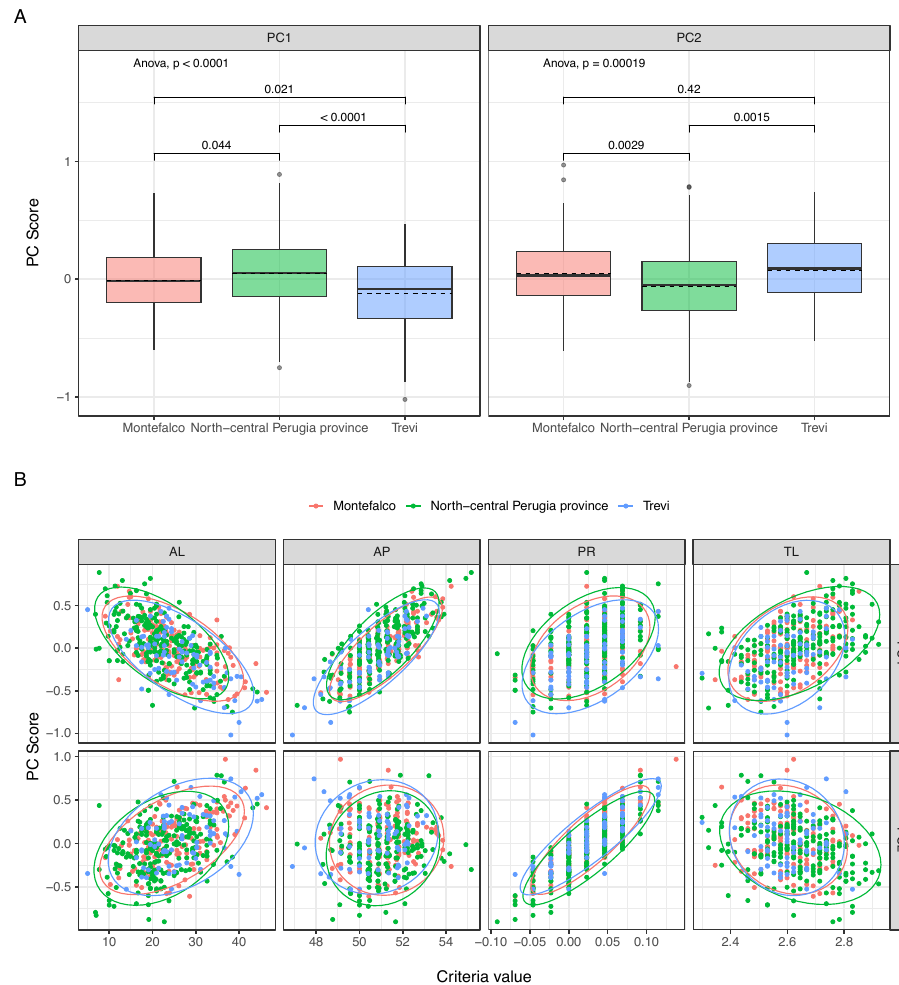
Figure 5. ( A ) Distribution of the row scores of the first two components of PCA. The p value of Bonferroni tests reveals whether significant differences are present between the geographical populations. Colours are consistent with those used in Figure 2. ( B ) Individual PC scores and odontometric variables. The ellipses contain 95% of the